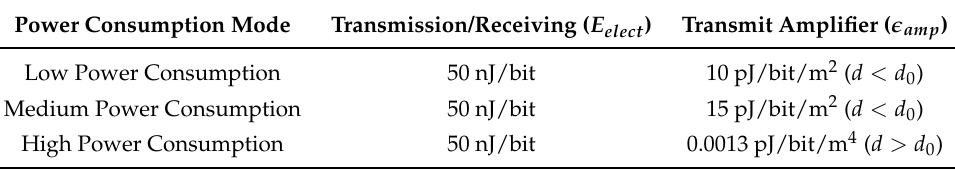
Table 8. Energy Dissipated For BEEM and Smart-BEEM.